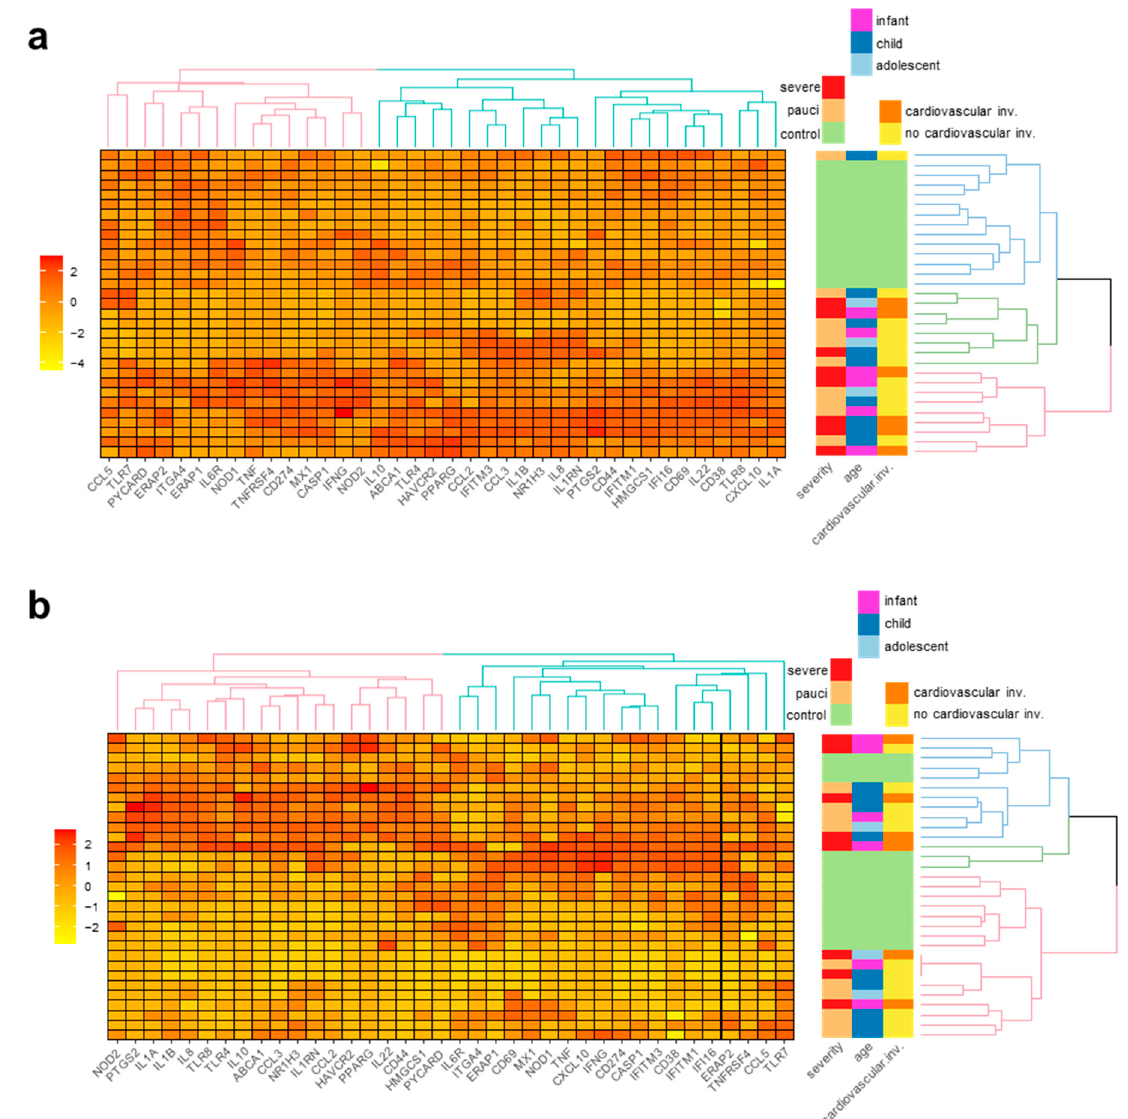
Figure 4. SARS-CoV-2-specific gene expression in PBMCs upon SARS-CoV-2-antigen-specific stimula- tion. Heatmap of gene expression levels in study subjects expressed using linear regression upon log transformation of the data and clustering (right panel) of the patients according to gene expression levels in the control and patient unstimulated (Panel a ) or SARS-CoV-2-stimulated PBMCs (Panel b ).